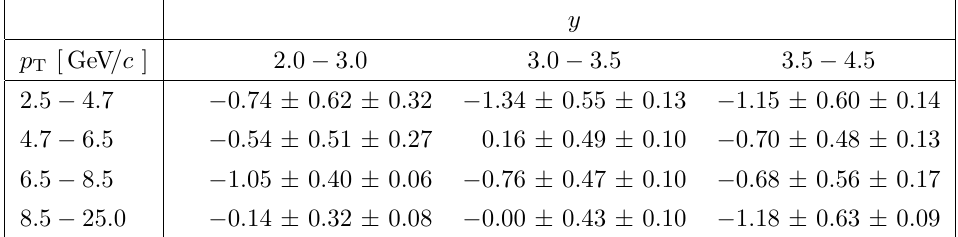
production asymmetry in percent, including, respectively, the statistical s kinematic bins using the s